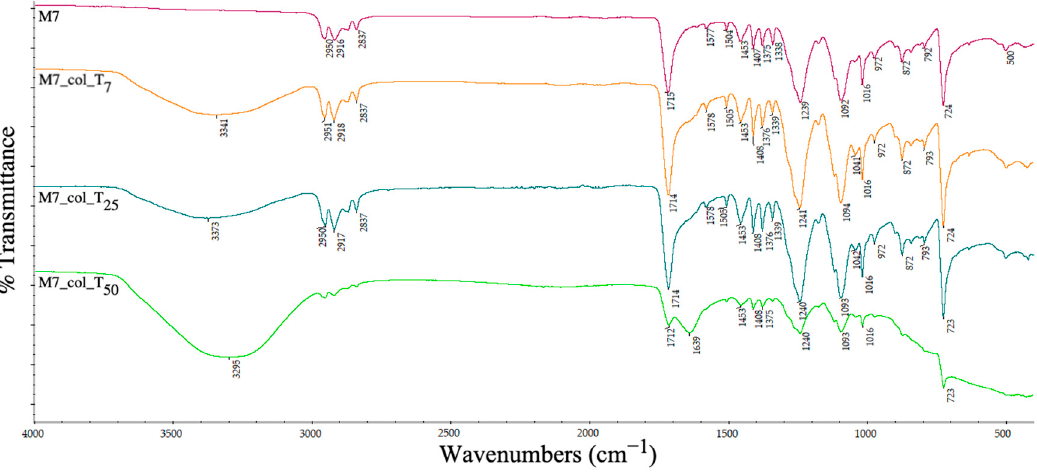
Figure 21. ATR spectra of PET–PP–Al nano-power composite pellets before and after collagen deposition at days 7 (T 7 ), 25 (T 25 ) and 50 (T 50 ).